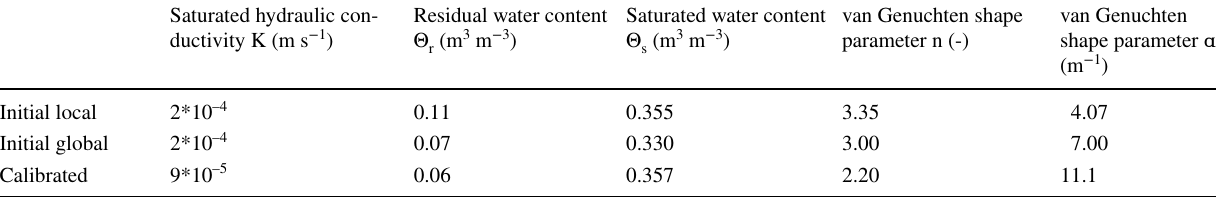
Table 3 Final hydraulic soil parameter set for soil 1 based on calibration